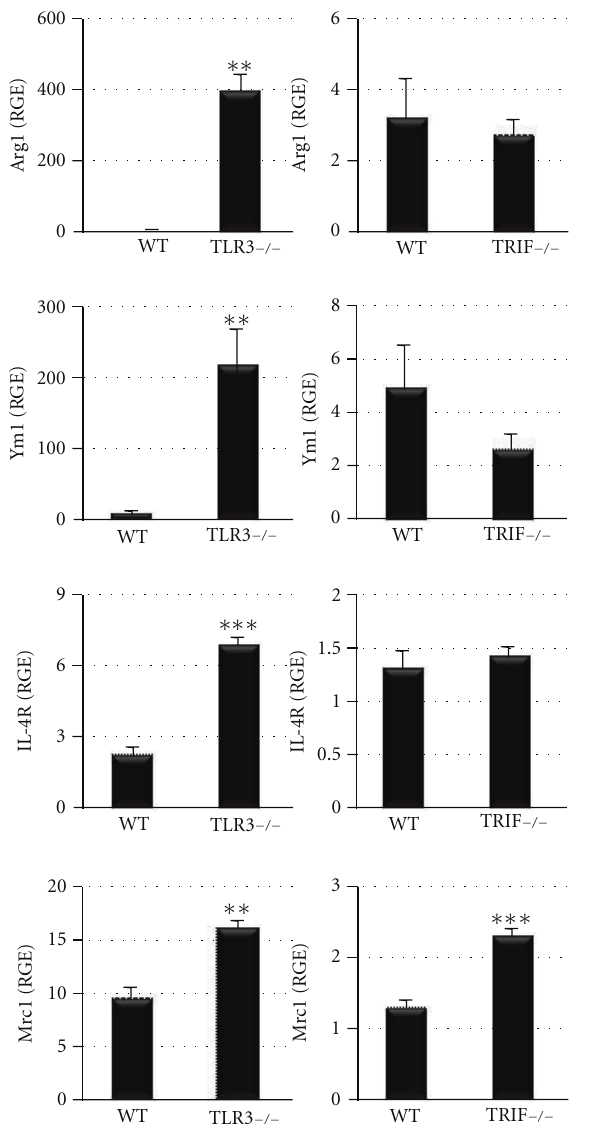
Figure 7: TLR3-deficient (TLR3 − / − ) mice have increased markers of IL-4-driven alternative activation compared to TRIF − / − mice. Markers of alternative activation included arginase-1 (Arg1), chiti- nase (Ym1), IL-4R, and macrophage mannose receptor (Mrc1) by qRT-PCR. Relative gene expression (RGE) was normalized to hypo- xanthine phosphoribosyltransferase 1 (HPRT). Data show the mean ± SEM of 10 mice/group. ∗∗ : P < 0 . 01; ∗∗∗ : P < 0 . 001.